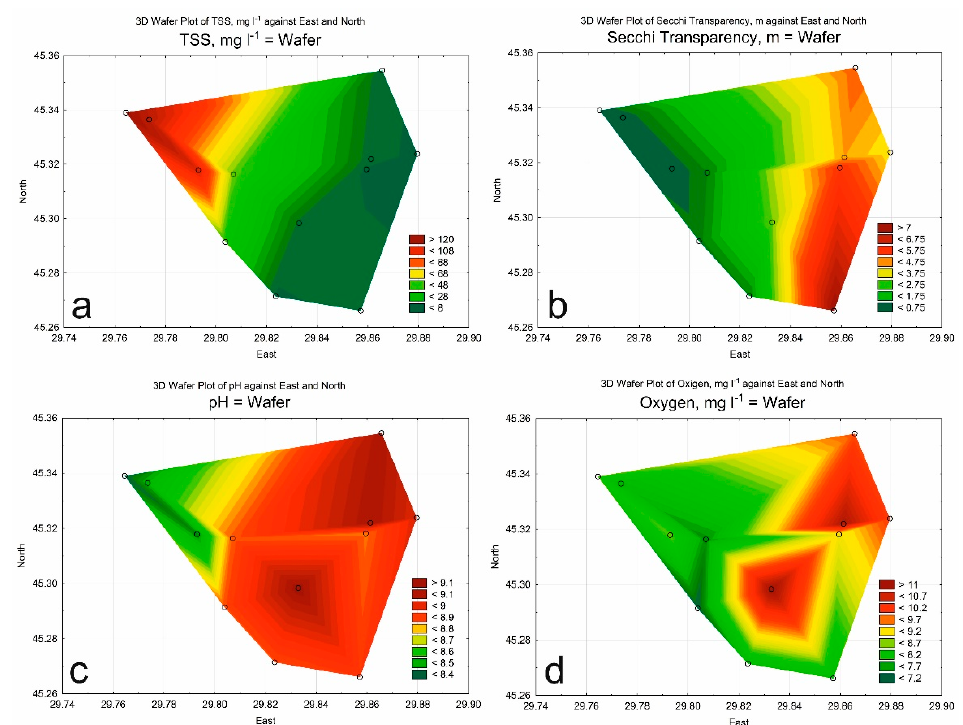
Figure 5. Statistically generated maps of nutrients from the bottom horizon in the Ukrainian part of the Danube nearshore area in August 2018: nitrates (NO 3– ) ( a ); dissolved organic nitrogene (DON) ( b ); dissolved inorganic phosphorus (DIP = РО 43– ) ( c ); dissolved organic phosphorus (DOP) ( d ).